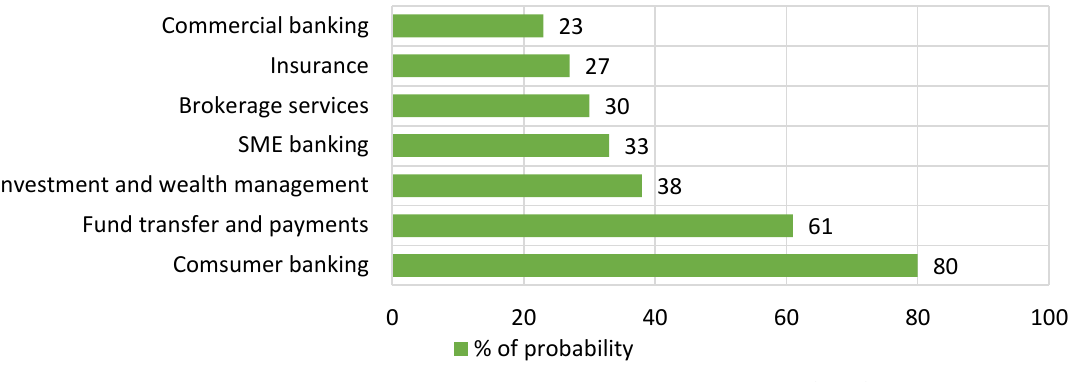
Figure 1. The probability of the global financial sectors (in %) to be disrupted by FinTech over